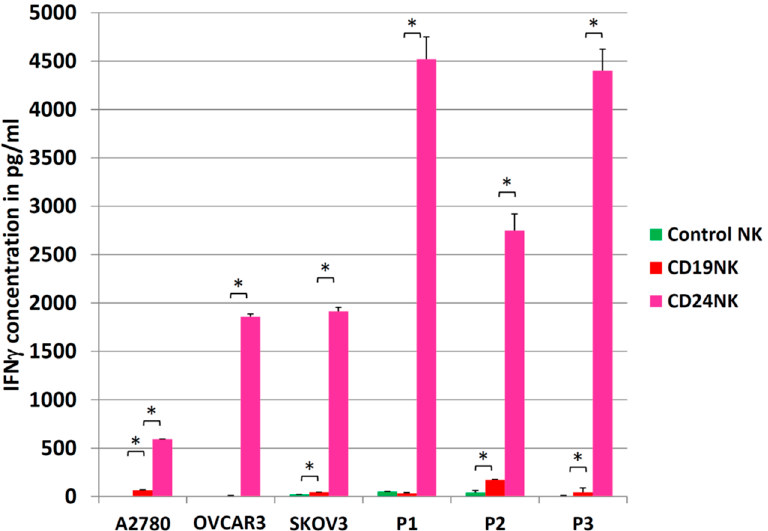
Figure 4. Anti-CD24-CAR-NK-92 cells produce high levels of IFN γ upon co-incubation with CD24-expressing cancer cells. IFN γ concentration in cell-free supernatants after co-culture for 24 h with an E/T ratio of 5:1 was measured by ELISA. Values represent the mean from two separate experiments each containing three samples. Control NK are unmodified NK-92 cells, CD19NK are CD19-CAR-NK-92 cells, and CD24NK are CD24-CAR-NK-92 cells. * indicate p -values < 0.01 (independent t -test).